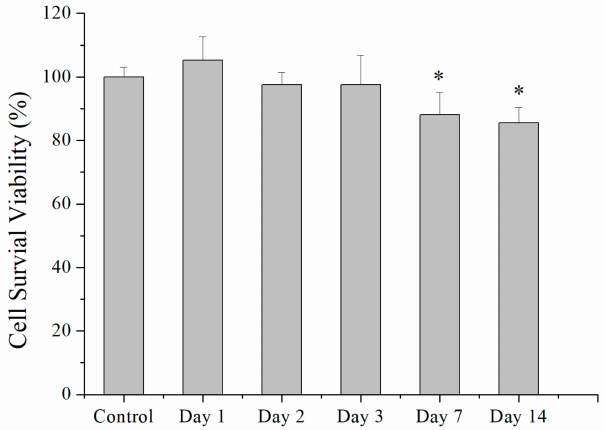
Figure 4. Cell viability of human fibroblasts treated with the eluents from analgesics-loaded microparticles incubated in phosphate-buffered saline for different periods. The asterisks denote significant differences from the control group. ( N = 3, * p < 0.05).